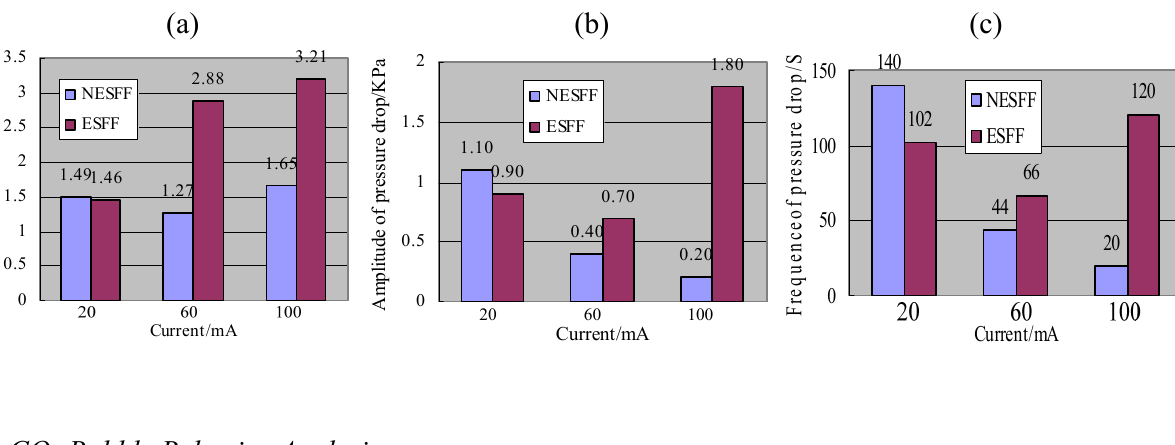
Figure 7. The histogram of the statistical pressure drops: (a) the average pressure drop, (b) the amplitude of pressure drop, and (c) the frequencies of pressure